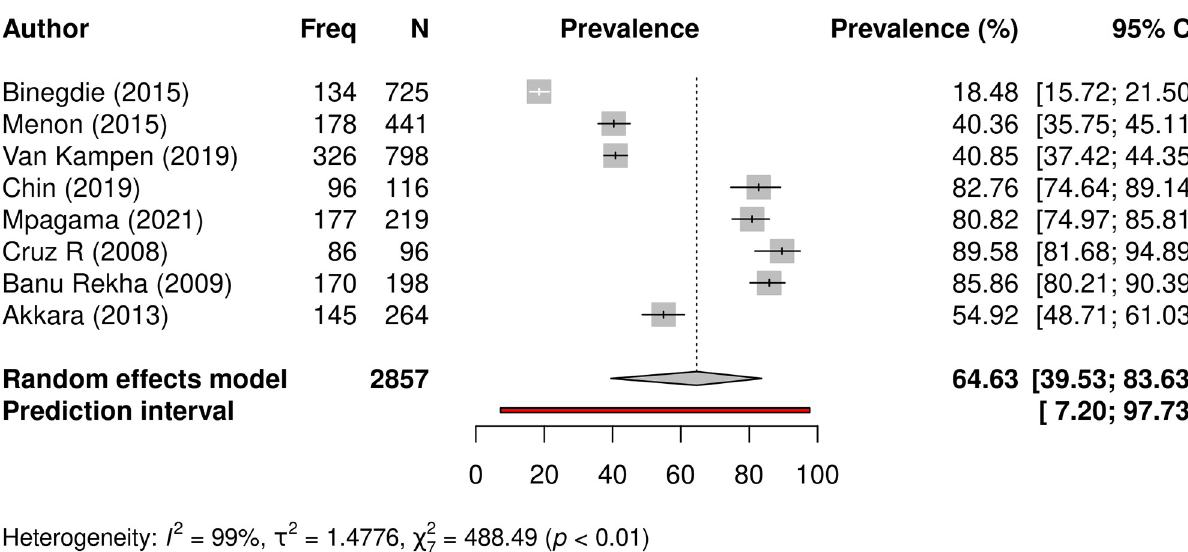
Fig 4. Prevalence of radiologic structural lung abnormalities following TB. A forest plot showing individual study prevalence and pooled prevalence of abnormal chest radiology in 8 studies that conducted chest imaging in a pooled sample of 2857 study participants post-TB.